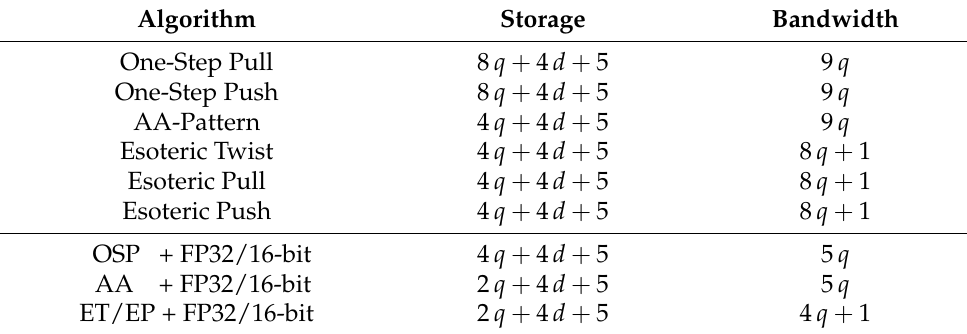
Table 1. Comparing memory storage (Bytes/node) and bandwidth (Bytes/node per time step) requirements of the different GPU-compatible streaming algorithms for DdQq LBM with FP32 arithmetic precision and eight available flag bits per node. With the in-place streaming and implicit bounce-back of the Esoteric schemes, and with FP32/16-bit mixed precision as proposed in [13], memory demands and bandwidth are significantly